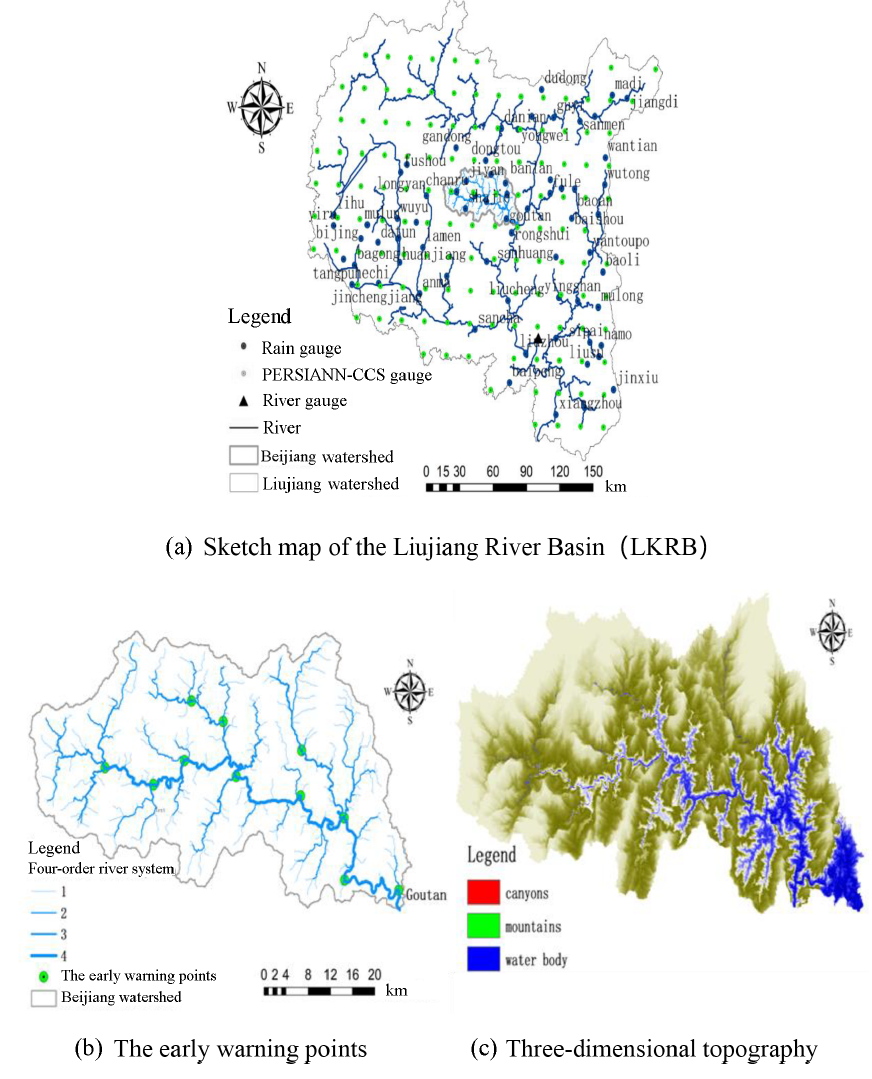
Figure 1. Sketch map of Liujiang and the Beijiang